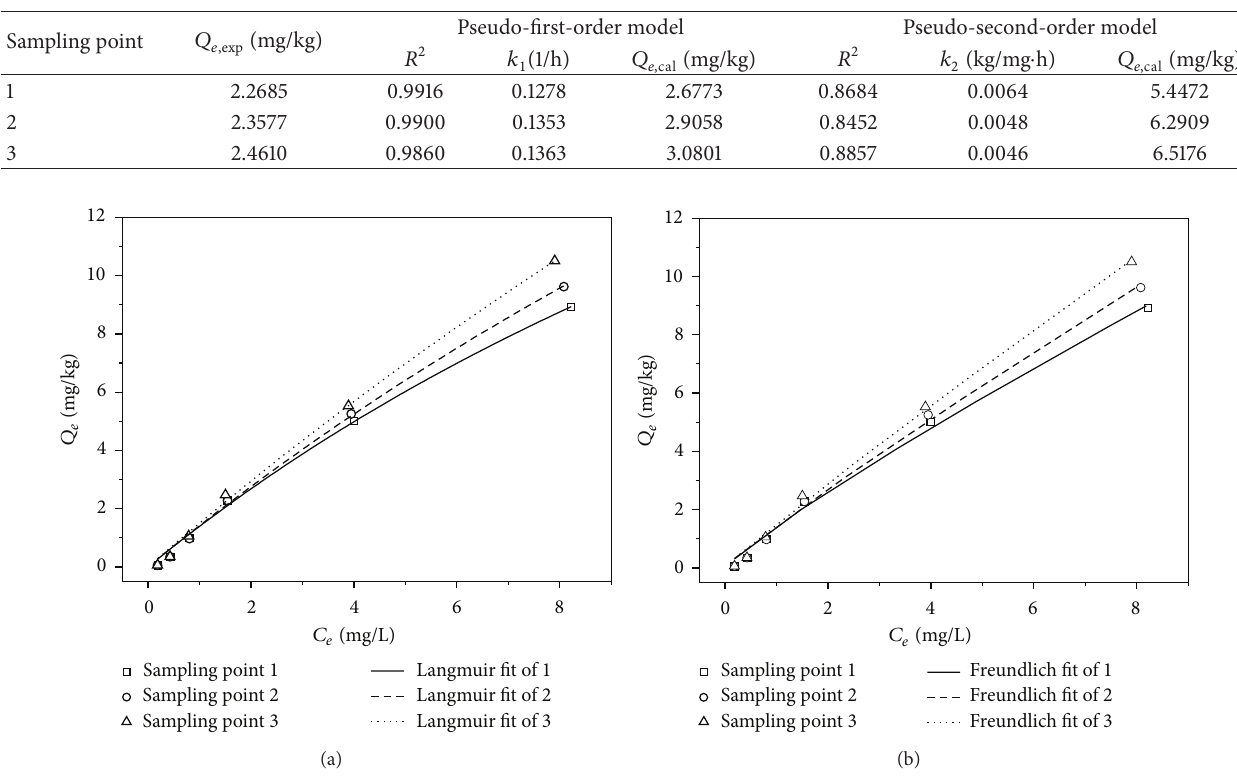
Table 2: Pseudo-first-order and pseudo-second-order rate constants for OTC adsorption onto sediment samples.